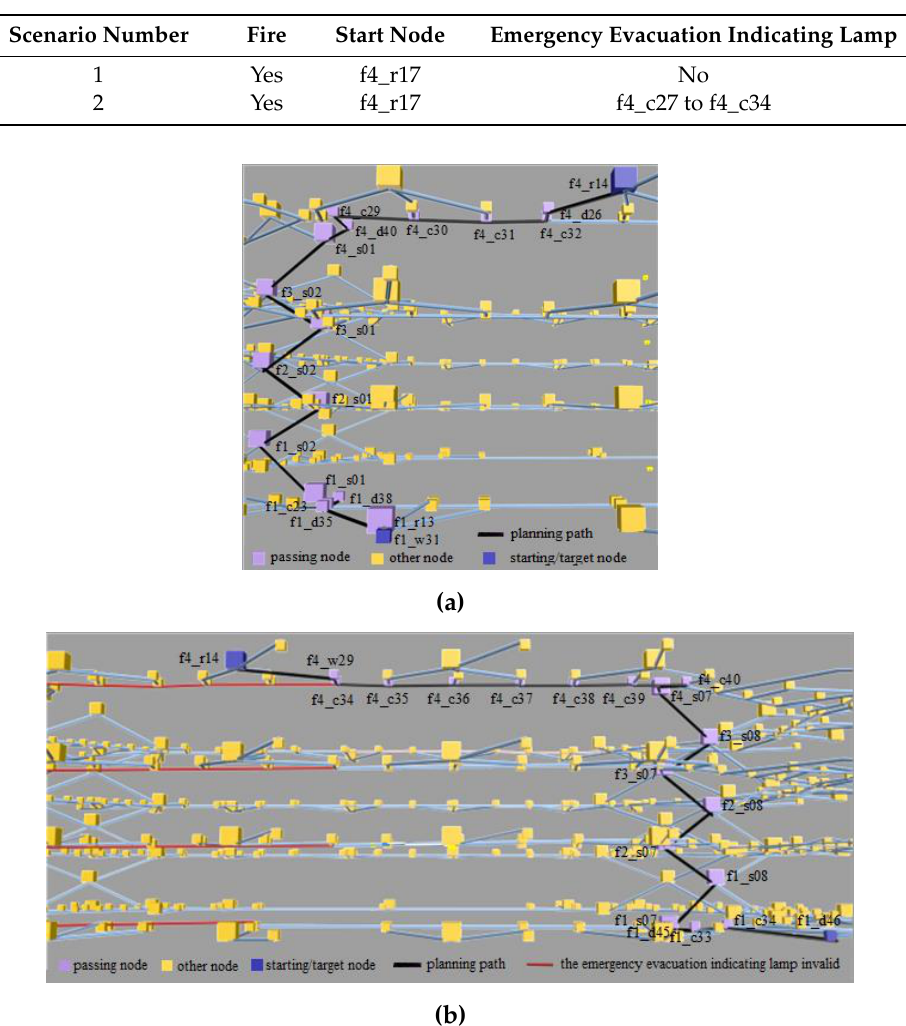
Table 6. Environmental semantics of experiment 2.